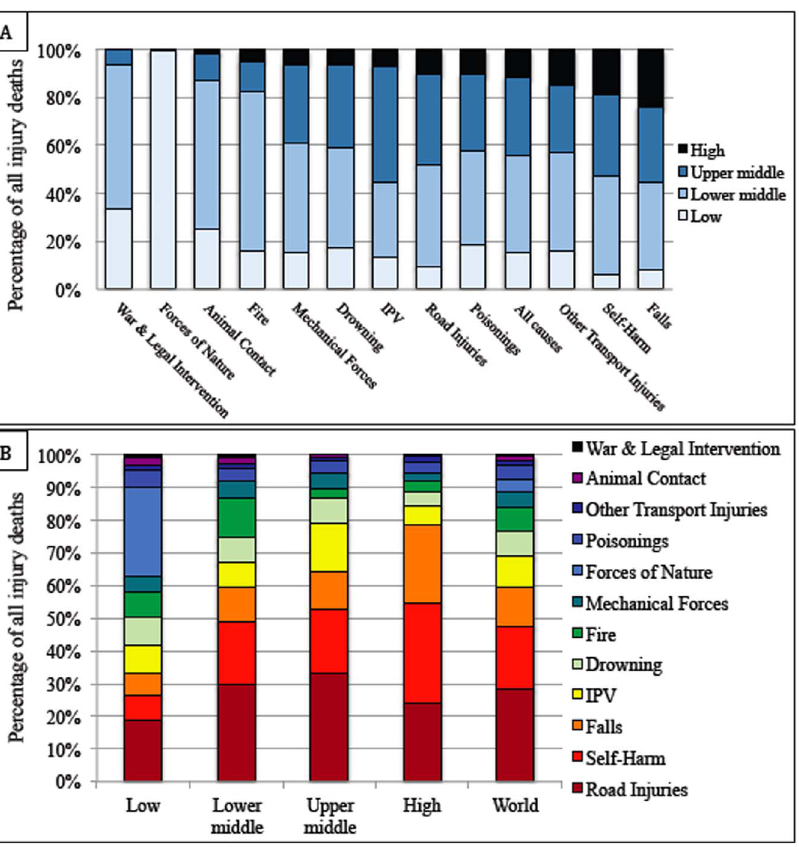
Figure 1. Percentage of total injury deaths by income level and injury type. A) Percentage of total injury deaths by income level for each mechanism of injury. The mechanisms of injury are sorted on the x-axis from greatest-to-least by the percentage of deaths occurring in LMICs. B) Percentage of total injury deaths by injury type in each income group. The mechanisms of injury are sorted in the columns from greatest-to-least by the percentage of total deaths occurring worldwide.